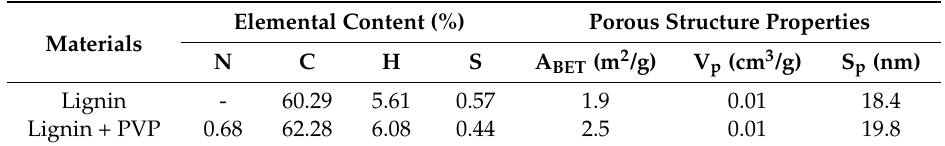
Table 3. Elemental content and parameters of porous structure properties of lignin and lignin + PVP samples.